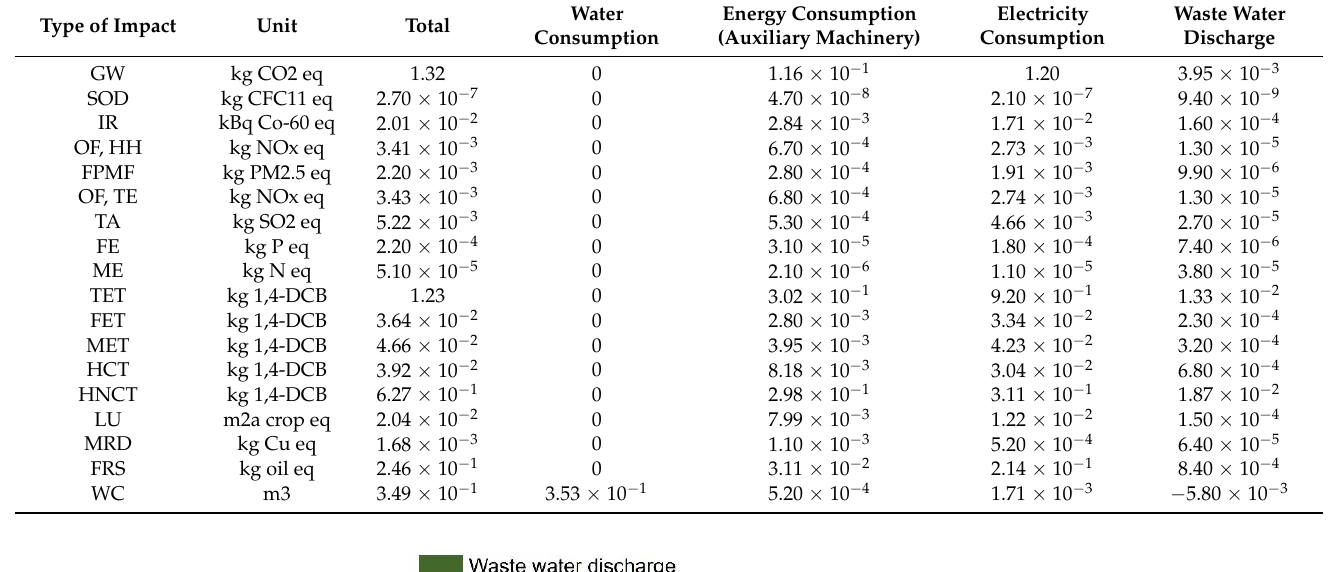
Table 4. Normalized LCA results for Scenario 1.